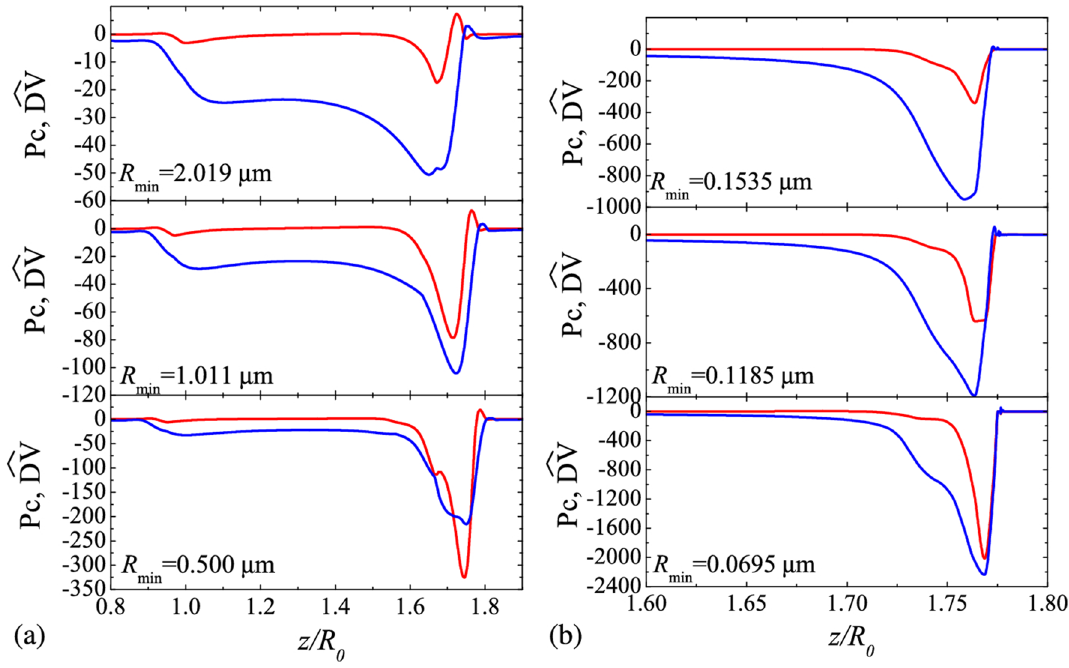
Figure 7. Axial distribution of the capillary stress Pc = ˆ σκ (blue lines) and normal dilatational viscous stress ∇ S · v S )κ (red lines) for DIW+SDS 0.8cmc and three instants as indicated by the value of R DV = Oh S min . The 2 ( S ∗ 0 , µ S ∗ 10 − 7 Pa s m } and µ S ∗ 0 , µ S ∗ 3.5 × 10 − 9 left-hand and right-hand graphs correspond to { µ 1 = 2 = 1 = 2 = (cid:31) Ŵ cmc = 1.002 , and Pa s m } , respectively. The results were calculated for B = 3.396 × 10 − 3 , Oh = 0.01510, S ∗ S = 7.730 × 10 4 0 , and Oh S ∗ 1.313 × 10 − 2 (left-hand graphs) and 4.594 × 10 − 4 Pe , Oh 1 = 2 = (cid:31)